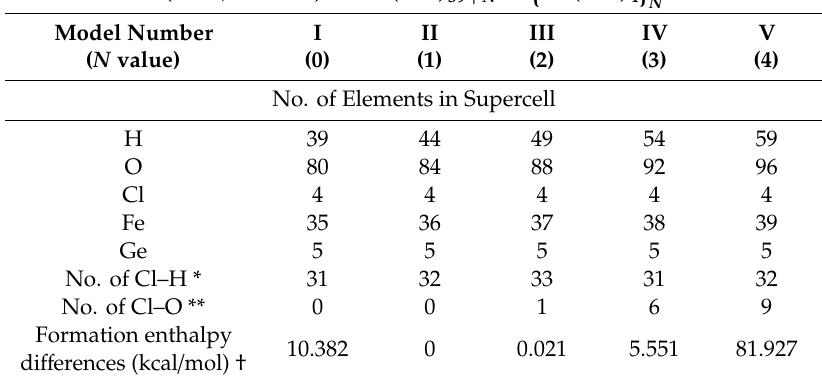
Table 3. Comparisons of formation enthalpy for five models after DFT-D calculations. Components are changed by the number of tunnel tetrahedra ( N value). The total enthalpy is also changed by the components and bonding structure. The formation enthalpy for the bonding structure is calculated by applying Equation